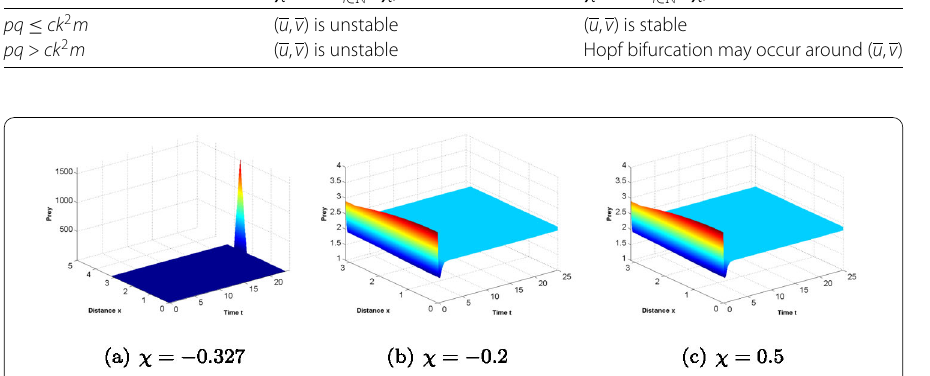
Table 1 The stability of positive equilibrium ( u , v ) for different χ and other parameters χ < max χ i χ > max χ i i ∈ N + i ∈ N + pq ≤ ck 2 m ( u , v ) is unstable ( u , v ) is stable pq > ck 2 m ( u , v ) is unstable Hopf bifurcation may occur around ( u , v